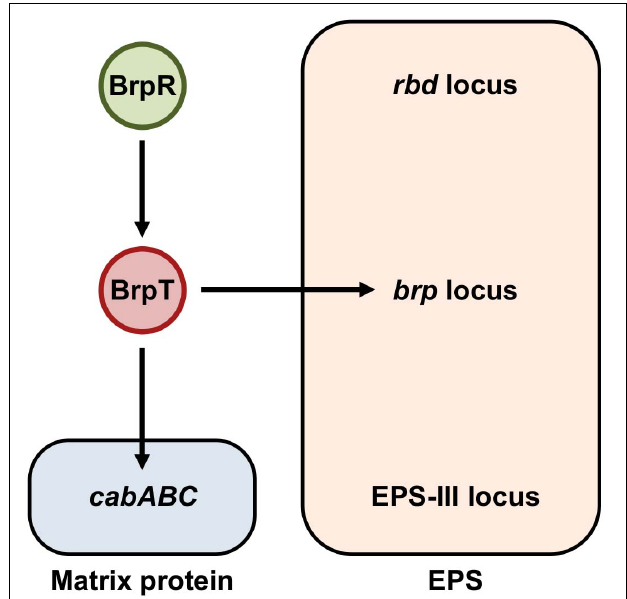
FIGURE 1 | BrpR and BrpT regulate the expression of the brp locus and cabABC in a sequential cascade. In V. vulnificus , BrpR induces the brpT expression, and BrpT in turn activates the expression of the brp locus and cabABC in a sequential manner. The brp locus and cabABC are responsible for the production of the brp -EPS and the matrix protein CabA, respectively, and together contribute to the development of a structured biofilm matrix. The genome of V. vulnificus contains three distinct loci, the rbd , brp , and EPS-III loci, responsible for EPS production. Among them, expression of only the brp locus is activated by BrpR and BrpT as